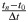
Convergence of estimates of S0 obtained using peak-to-peak iteration (PTPI).S0 was estimated by applying PTPI (25 iterations) to 1000 incidence time series (i.e., 1000 realizations of a reported incidence time series, scaled by prep-1). An initial guess for S0 was taken to be 14 or 4 times the true (data-generating) value. For each initial guess, this process generated 1000 sequences of 26 estimates of S0. Plotted are the median [black lines] and 5th–95th percentile range [grey bands] of the estimate of S0 at each iteration, for the first 10 iterations. The vertical axis measures (on a logarithmic scale) the ratio of the estimated and true values of S0, hence convergence close to 1 [dashed green line] represents convergence of the estimates close to the true value. [Details] One thousand reported incidence time series (Δt = 1 week, n = 1042) were simulated with environmental noise in transmission (ϵ = 0.5), demographic stochasticity, and random under-reporting of cases (prep = 0.25), using reference values (Table 1) for the remaining parameters, including S0 (hence S0 was the same in all simulations). True incidence was estimated from reported incidence via Eq (26a) (with reporting parameters prep and trep correctly specified), yielding 1000 time series of estimated incidence. Corresponding mock (constant) birth and natural mortality time series were created (with vital rates νc and μc correctly specified), and these data (estimated incidence, births, natural mortality) were passed to the PTPI algorithm, allowing for iterative re-estimation of S0.